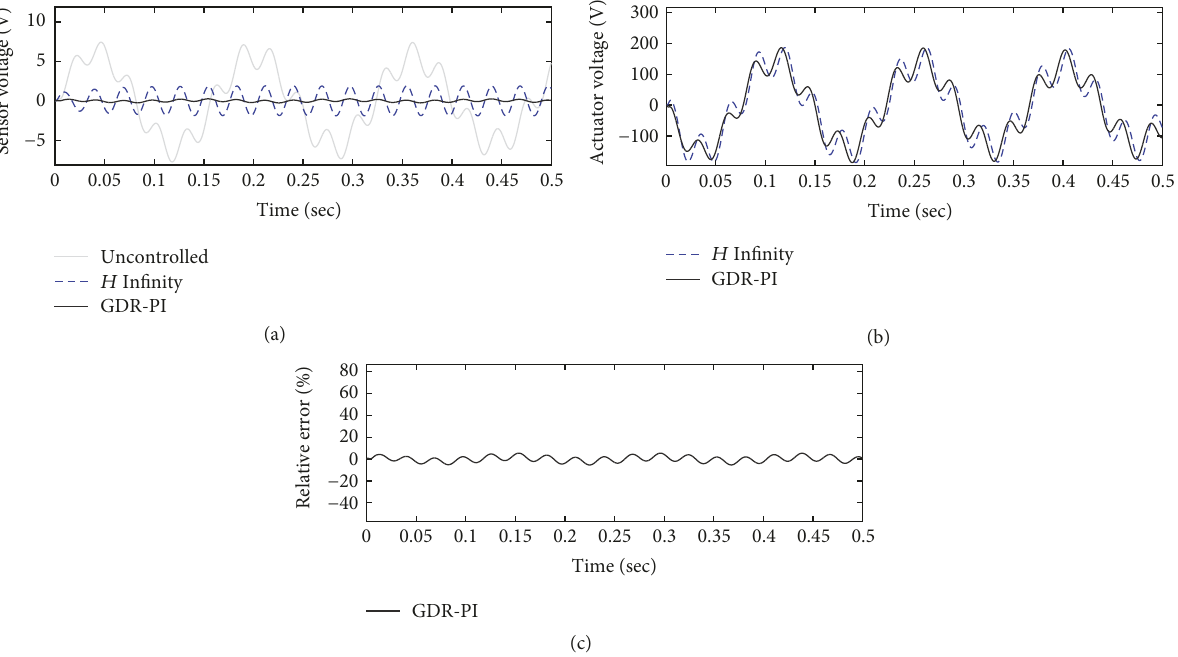
Figure 7: The time domain response of the controlled and uncontrolled smart beam under two harmonic disturbance with the second eigenfrequency applied at 𝑃 1 and 𝑃 3 : (a) sensor output, (b) control input, and (c) relative error of estimated disturbance.